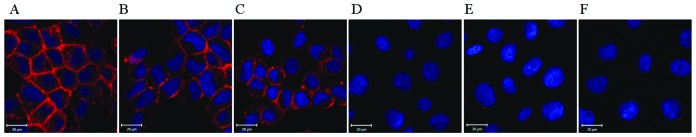
Downregulation of PSMA expression in androgen-deprived LNCaP cells by PSMA’s affinity labeling agent Cy5.5-CTT-54.2. (A) LNCaP cells cultured in normal growth media, serve as positive controls. The following LNCaP cells were treated with androgen deprivation for 2 days (B). (C) Five passages. (D) Ten passages. (E) Twenty passages. (F) PSMA-negative PC-3 cells. The nuclei were counterstained with Hoechst 33342. The cellular imaging was visualized by confocal microscopy; distance scale is 20 μm.